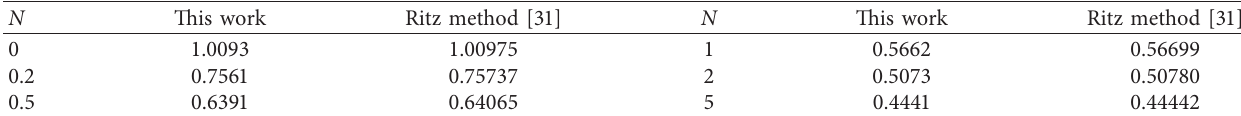
L 4 w of the FGM beam under uniformly distributed load resting 0 max